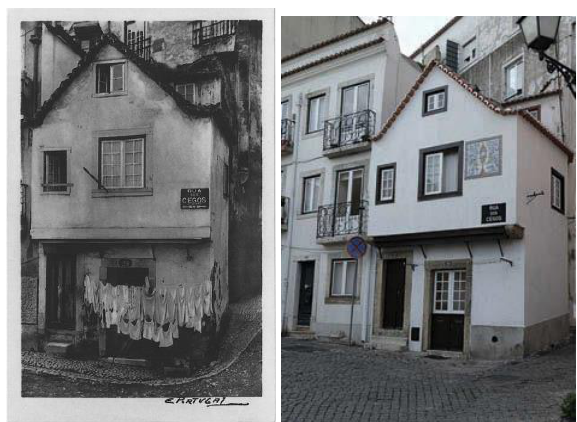
Figure 2. Main façade of case study No.1, Rua dos Cegos no.20, Lisbon: (left) in 1940s (Passos, 1997) vs (right) in